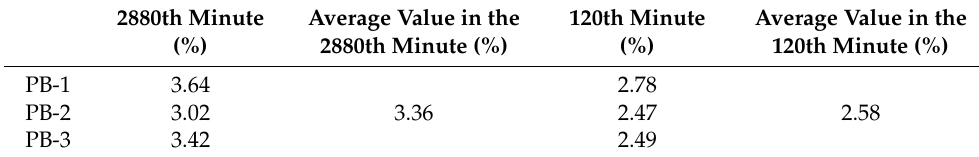
Table 4. Lateral restricted-swelling